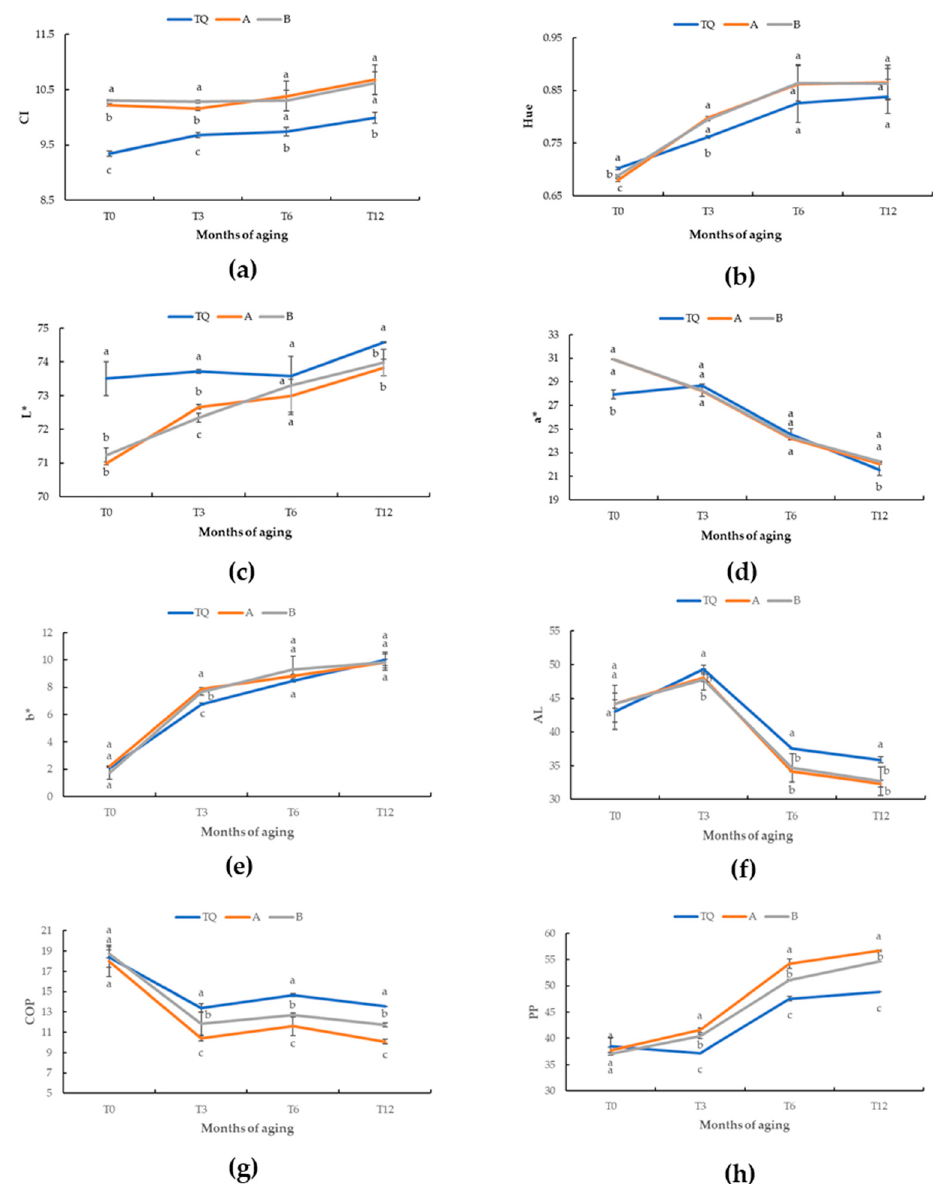
Figure 2. Evolution of several parameters during the aging period (12 months) in the wine treated with different stabilizing products: ( a ) color intensity (CI); ( b ) color hue (Hue); ( c ) lightness (L*); ( d ) red/green (a*); ( e ) blue/yellow (b*); ( f ) color fraction due to the fact of free anthocyanins (AL); ( g ) color fraction due to the fact of copigmentation (COP); ( h ) color fraction due to the fact of polymeric pigments (PP). Treatments: TQ (SO 2 ); A (UGE, 200 mg/L and chitosan); B (UGE, 400 mg/L). Different letters indicate significant differences among the samples according to the Tukey’s least significative difference (LSD)